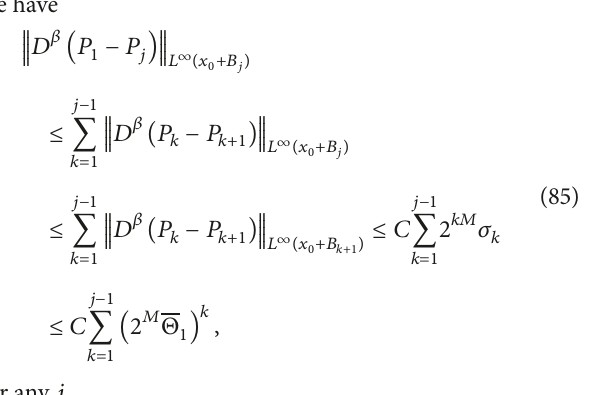
Figure 2: Boxplot of the distance between 1/2 and the estimated H¨older exponent. The left boxplot corresponds to the usual method and the other corresponds to a method involving the logarithmic